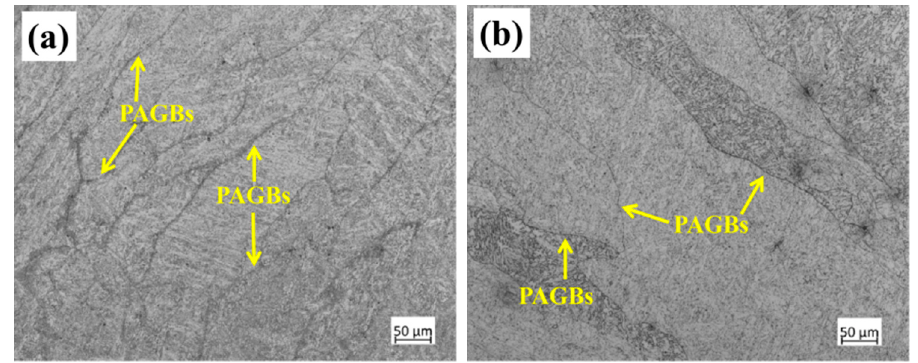
Figure 10. Optical microscopy ( OM) images of columnar grain zone of ( a ) as-welded specimen and ( b ) PWHT specimen.